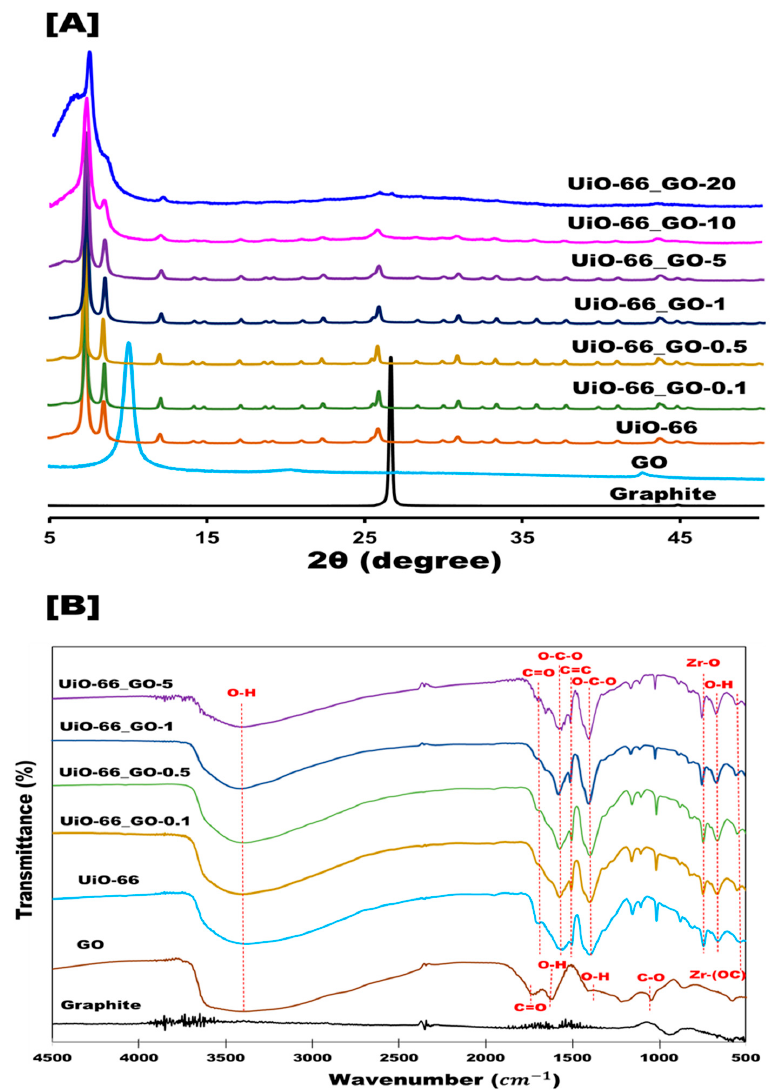
Figure 1. ( A ) XRD patterns and ( B ) FTIR spectra of graphite, GO, UiO-66, and UiO-66_GO composites.